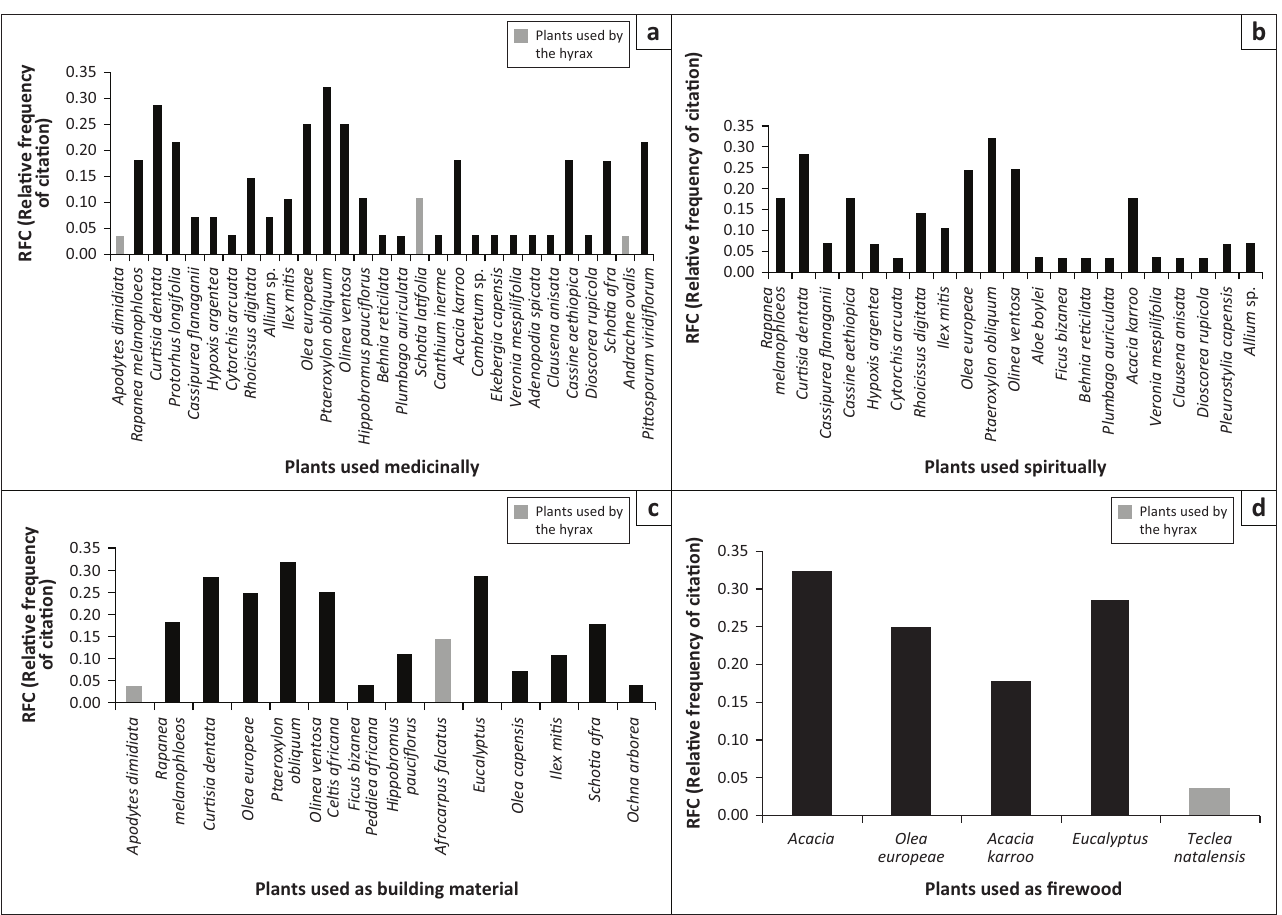
FIGURE 4: The relative frequency of citation for plants used (a) medicinally, (b) spiritually, (c) as building materials and (d) as firewood by harvesters in the Pirie forest. Plant species used by the tree hyrax as dens are indicated in